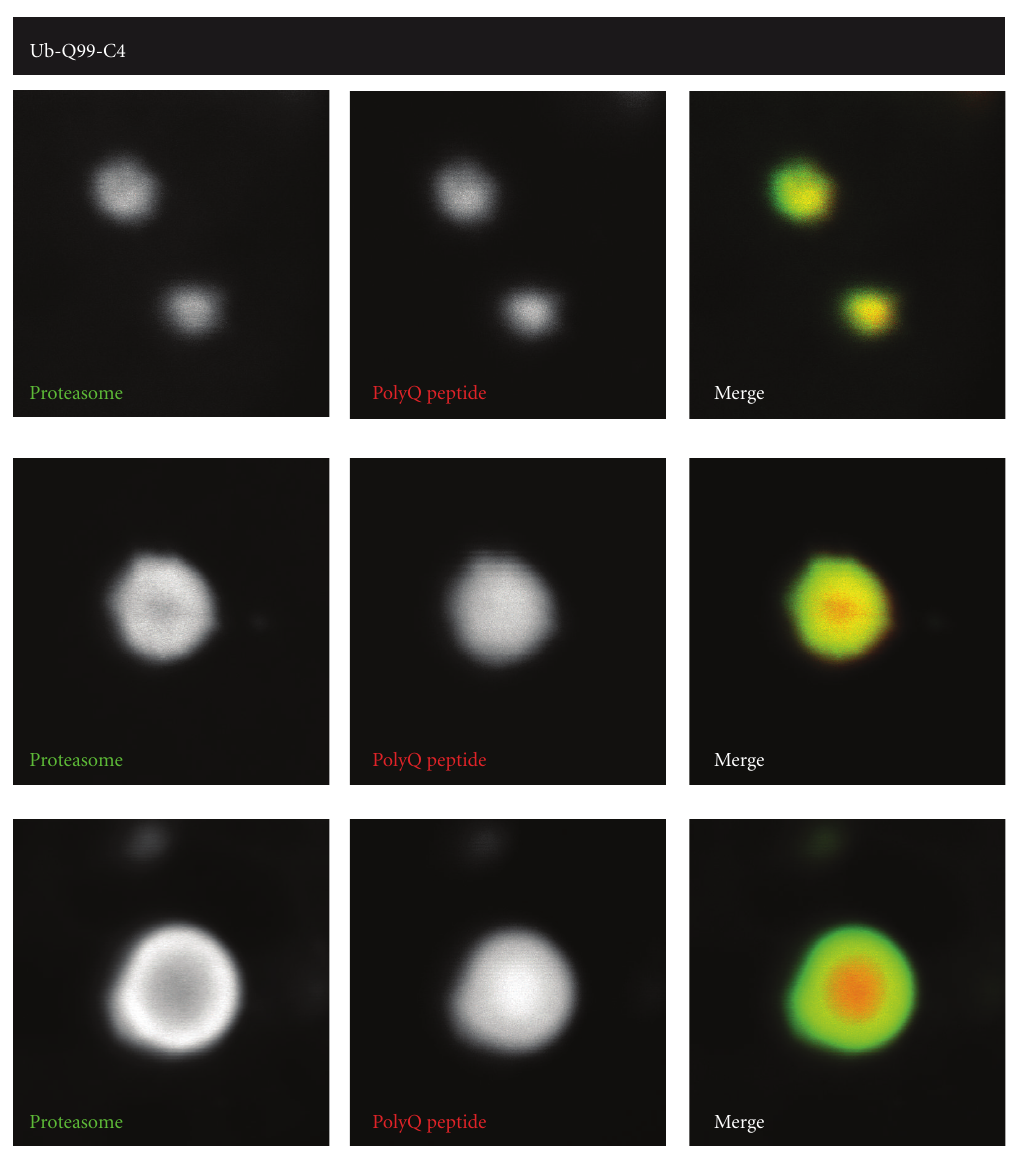
Figure 2: Localization of proteasomes in polyQ aggregates. Upon expression of red-labeled polyQ peptides in Hela cells, initially small aggregates appear (upper panel) which also recruit green-labeled proteasomes. However, in larger polyQ peptide containing aggregates the proteasome is only present in the outer layers, suggesting that proteasomes are not irreversibly trapped in